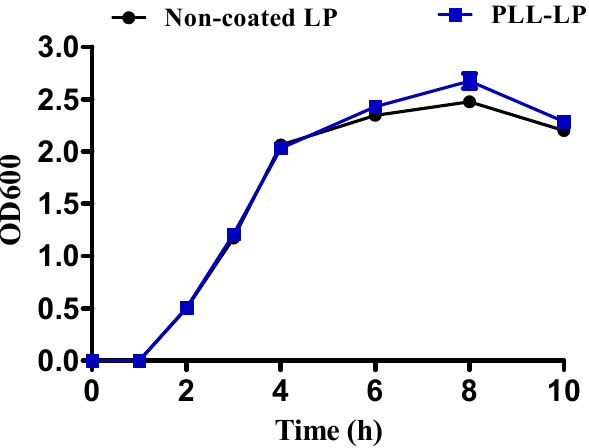
Figure 3. Growth pattern of non-coated L. plantarum (non-coated LP) and PLL-coated L. plantarum (PLL-LP) incubated in MRS broth for 10 h at 37 ◦ C. The error bar represents the standard deviation ( n = 3).